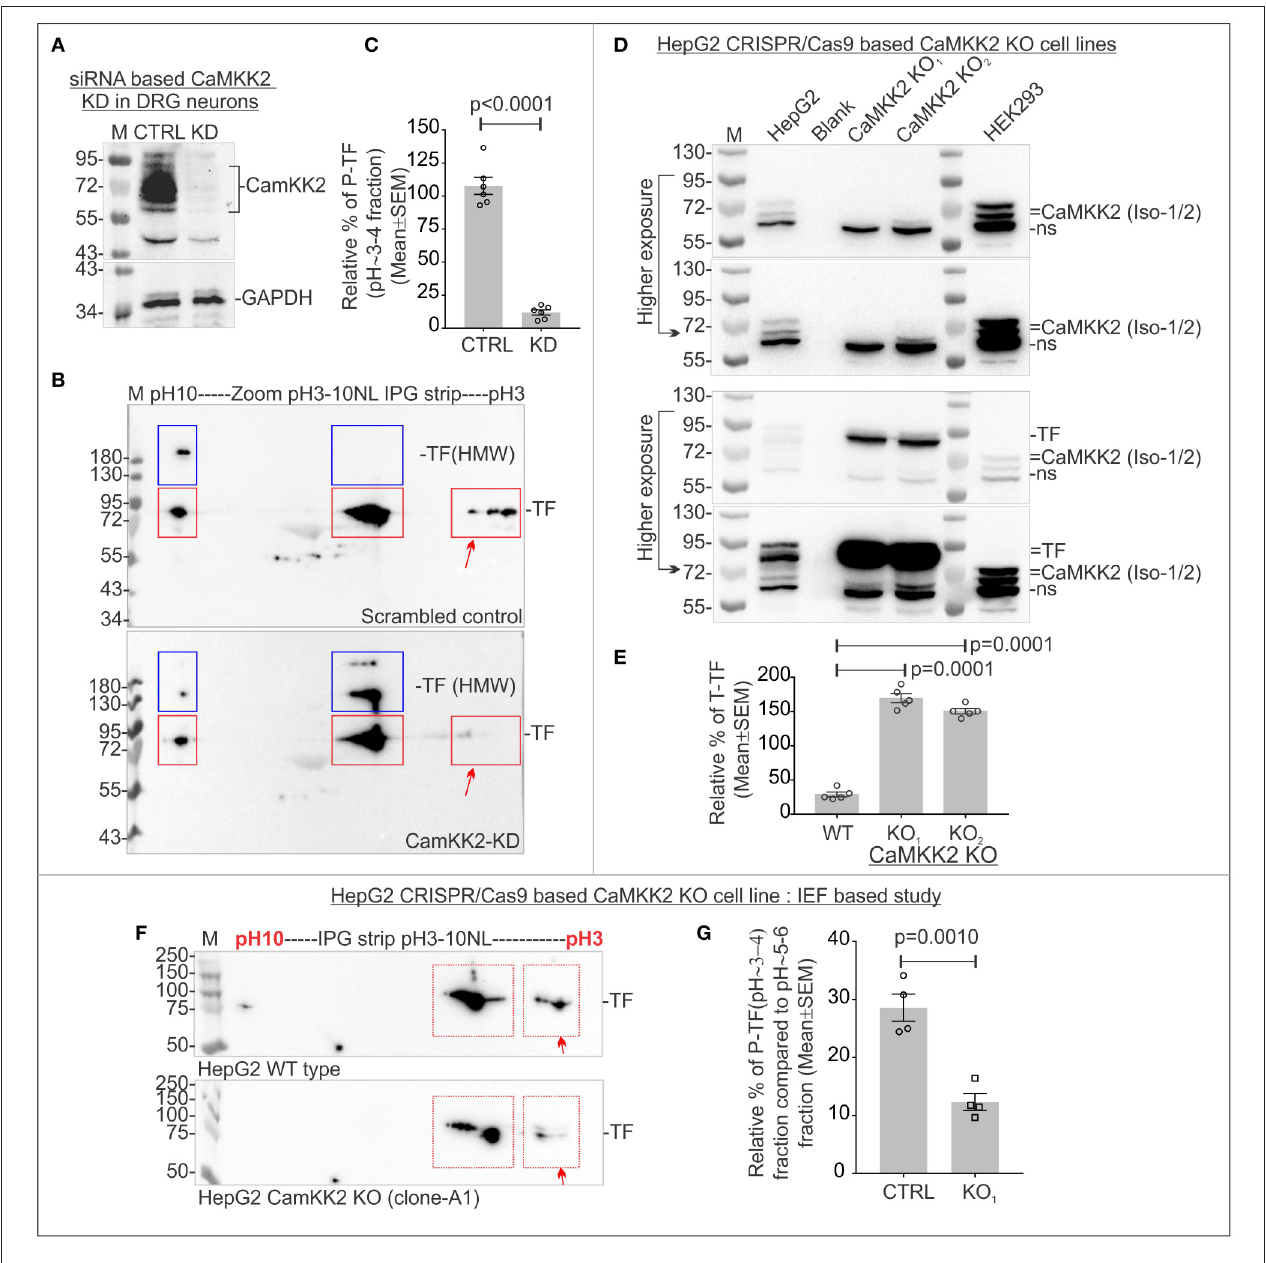
FIGURE 2 | P-TF significantly reduced in the CaMKK2 KD cultured primary adult rat DRG neurons and multiple CaMKK2 KO human cell lines. (A) Immunoblots showing relative expression of CaMKK2, and GAPDH in CaMKK2 KD DRG neurons. CTRL, scrambled control; KD, knockdown. (B) Immunoblots showing charged fractions of TF in the DRG neurons. Red rectangles indicate pH/pI ∼ 3, ∼ 5-6 and ∼ 9-10 fractions of native TF. Blue rectangles indicate higher molecular weight (HMW) form of the TF. (C) Scatter plot showing relative percentage of P-TF. The percentage was normalized relative to the intensity of pH ∼ 9-10 fraction. N = 6 from 3 independent experiments. The p -value by t -test (unpaired). (D) Immunoblots showing expression of CaMKK2 and TF in CRISPR/Cas9 based CaMKK2 KO HepG2 cells and wild-type HEK293 cells. KO 1 and KO 2 represent independently selected CaMKK2 KO HepG2 clonal cell lines. Different exposure of the same blot was given to highlight bands at different intensities. (E) Scatter plot showing the relative amount of total TF. The percentage was calculated relative to GAPDH (not shown) intensity. N = 6 from 2 independent experiments. The p -value by t -test (unpaired). (F) Immunoblots showing charged fraction of the TF in the wild-type (WT) and CaMKK2 KO 1 HepG2 cells. (G) Scatter plot showing the relative amount of P-TF. The relative intensity of the P-TF was calculated based on the intensity of pH ∼ 5-6 fraction. N = 4 from 4 independent experiments. The p -value by t -test (unpaired).